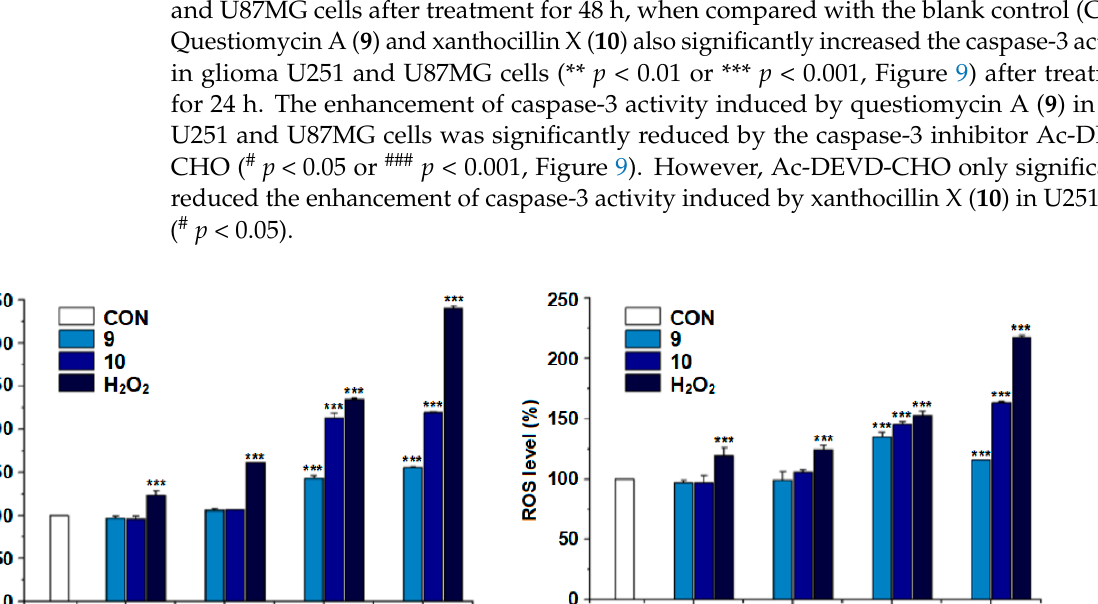
Figure 8. Effect of questiomycin A ( 9 ) and xanthocillin X ( 10 ) on the MMP in glioma U251 and U87MG cells. Glioma U251 and U87MG cells were treated with 9 (20 µM), 10 (20 µM), and BTZ (16 µM) at different time points. Data are presented as the mean ± SD, n = 4; * p < 0.05, ** p < 0.01 or *** p < 0.001 (vs. CON).